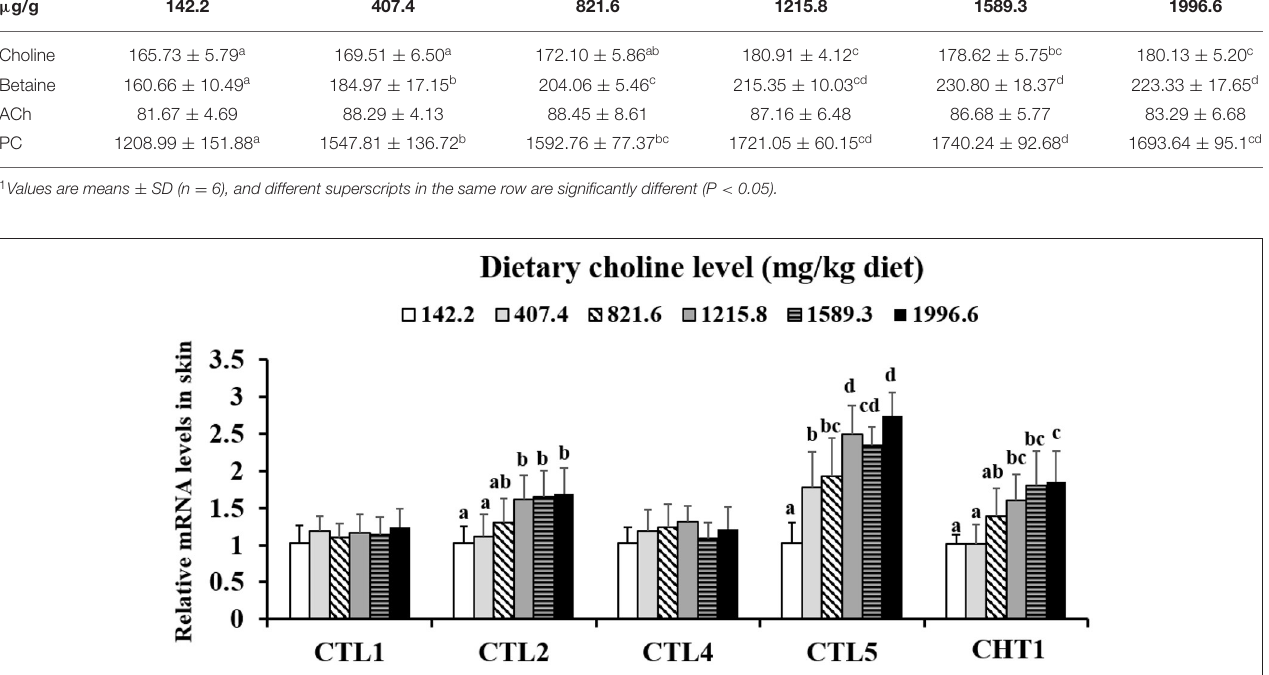
LZ in grass carp skin increased as the dietary choline level increased to 1215.8 mg/kg ( P < 0.05), then plateaued. The